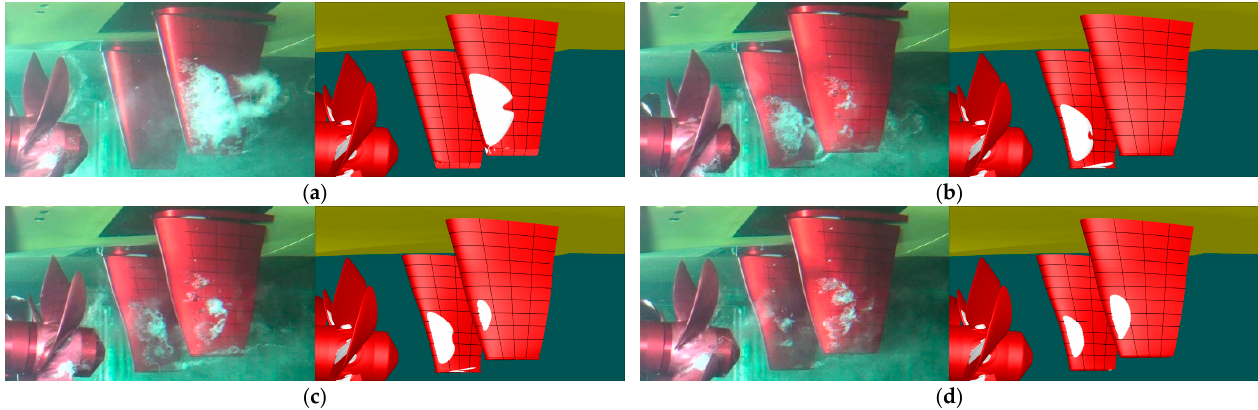
Figure 16. Experimental observation and numerical prediction of surface cavitation on the twin twisted rudders at δ R = − 6°: ( a ) flat rudder; ( b ) TR-ini; ( c ) TR-int; ( d ) TR-fin.